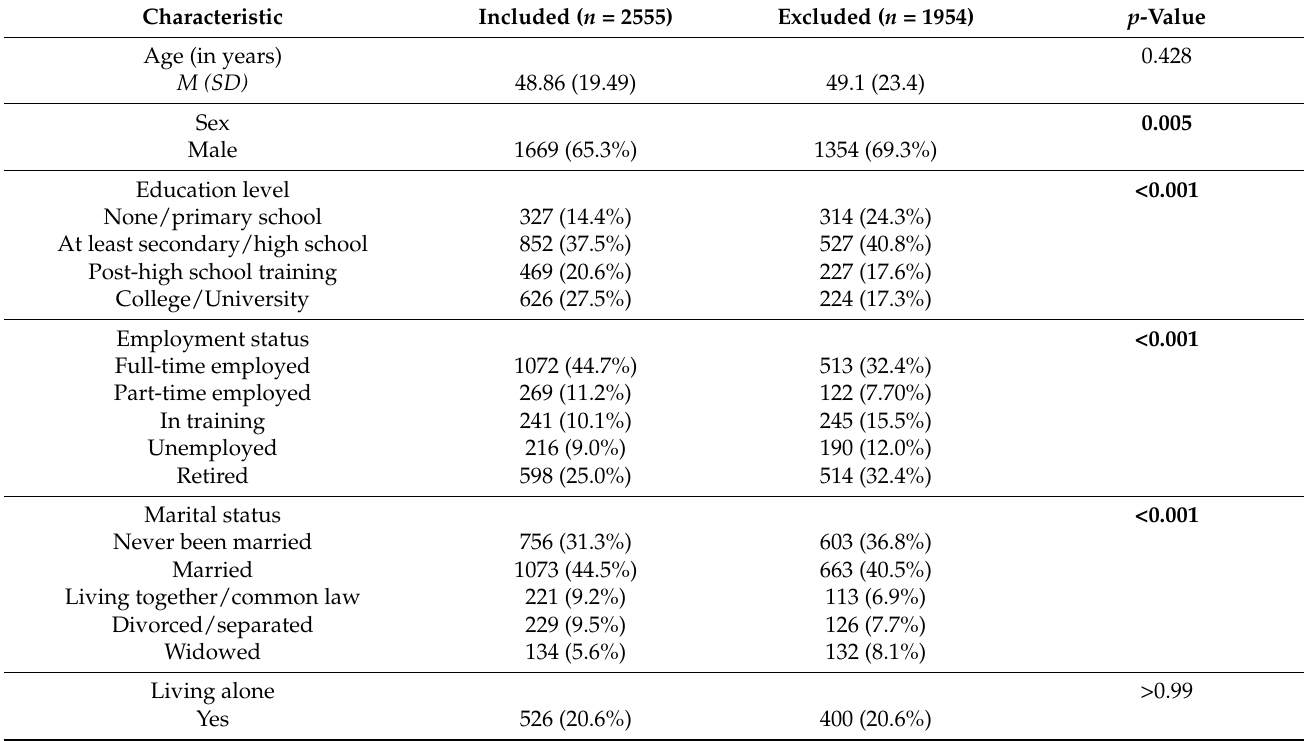
Table A1. Descriptive sociodemographic statistics for included and excluded